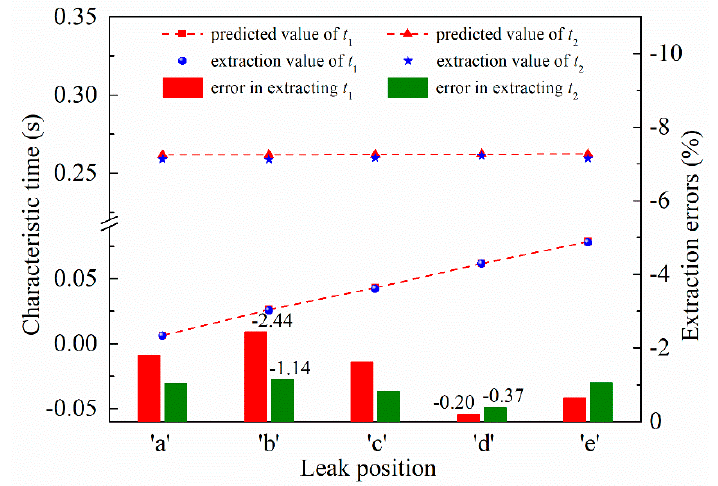
Figure 13. Predicted values, extraction values, and extraction errors of t 1 and t 2 for different leak positions.